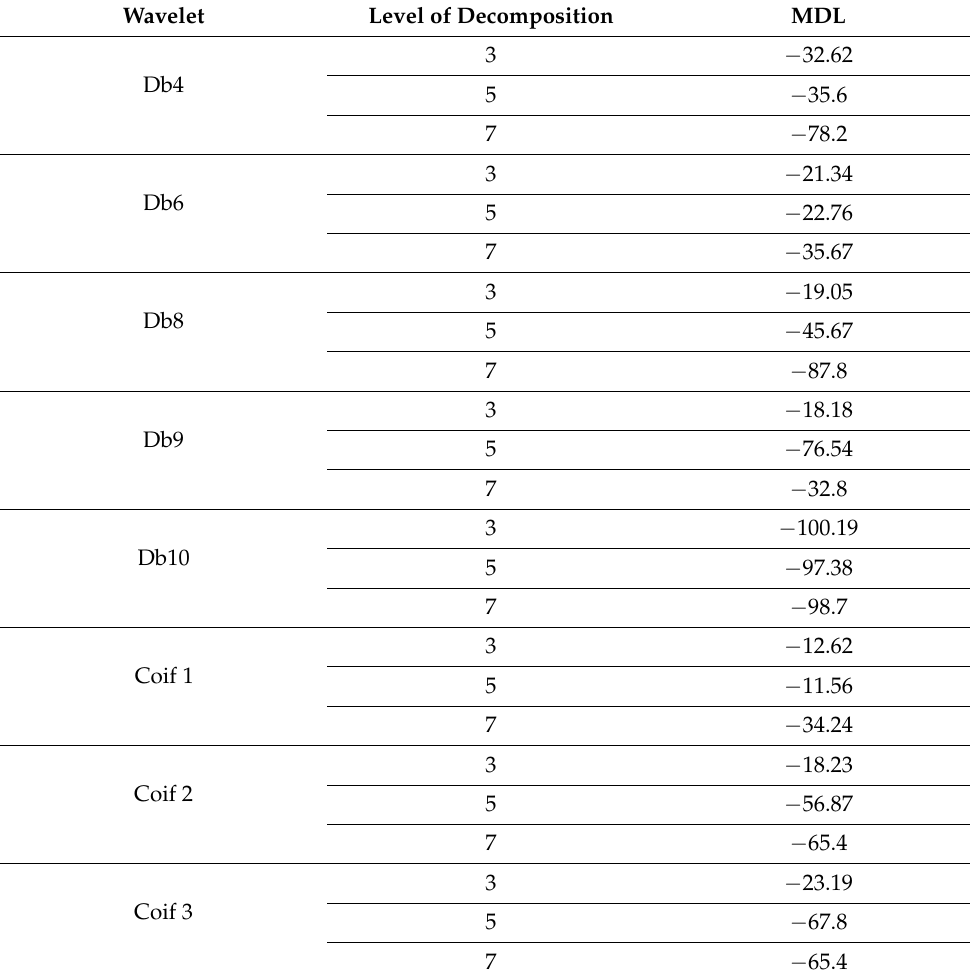
Table 1. Choice of mother wavelet and decomposition level. Wavelet Level of